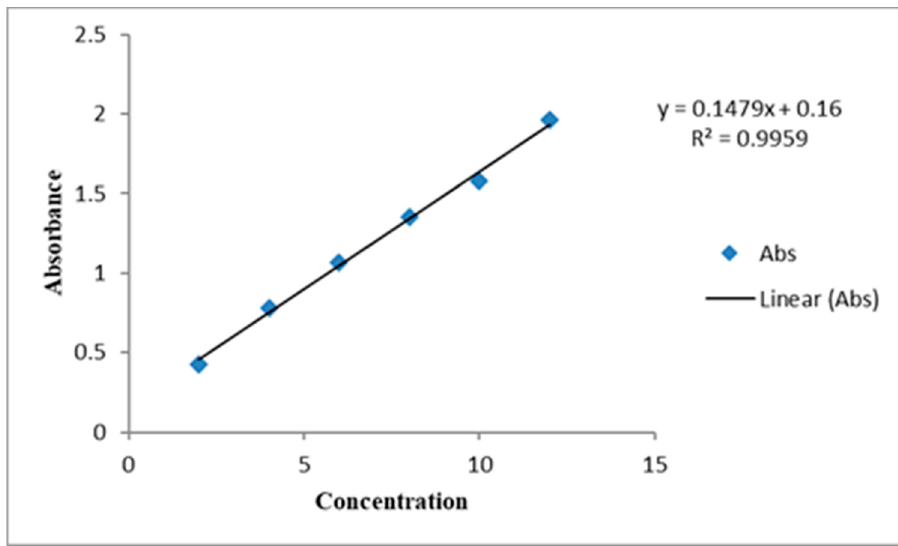
Figure 2. Standard calibration curve of EBZ.